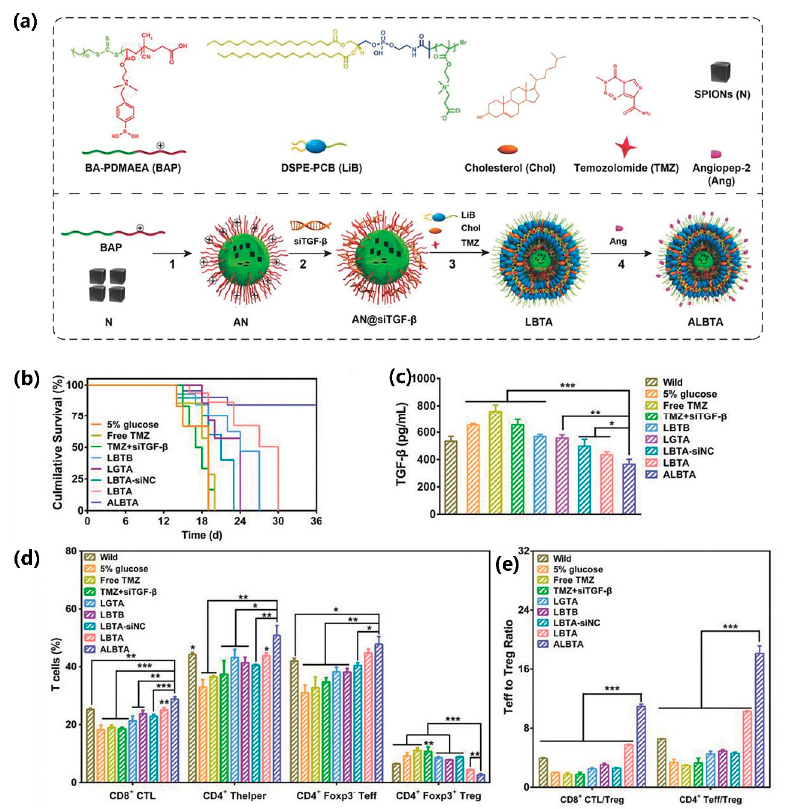
Figure 7. ( a ) Preparation of DSPE-PCB coated BAP/SPIONs@siTGF- β NPs. ( b ) T cell composition of different groups. ( c ) CD8 + cytotoxic lymphocyte cells (CTL): Treg ratios and CD4 + effector T cells: Treg ratios in spleen upon various treatments. ( d ) The survival time of different groups of intracranial glioblastoma-bearing mice after various treatments. ( e ) The regulation of TGF- β secretion after treatment with various formulations in vivo. *: differences between ALBTA with other groups, *: p < 0.05, **: p <